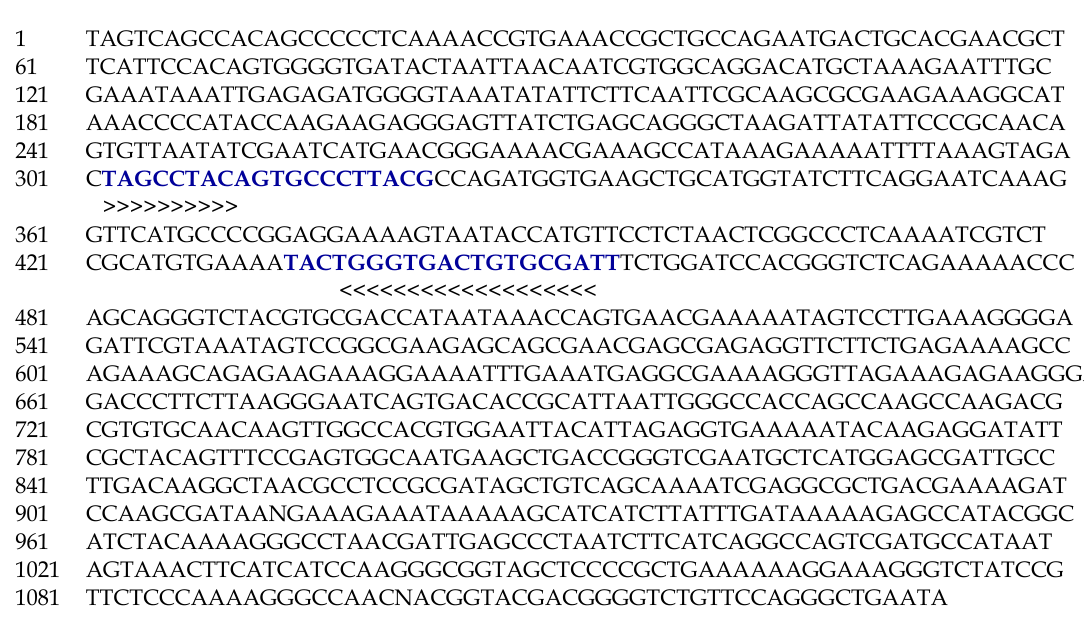
Figure 4. Sequence of cloned RAPD amplicon. Blue colored nucleotides show primer positions. Table 5. Sequence of SCAR primers, PCR condition, and product size.